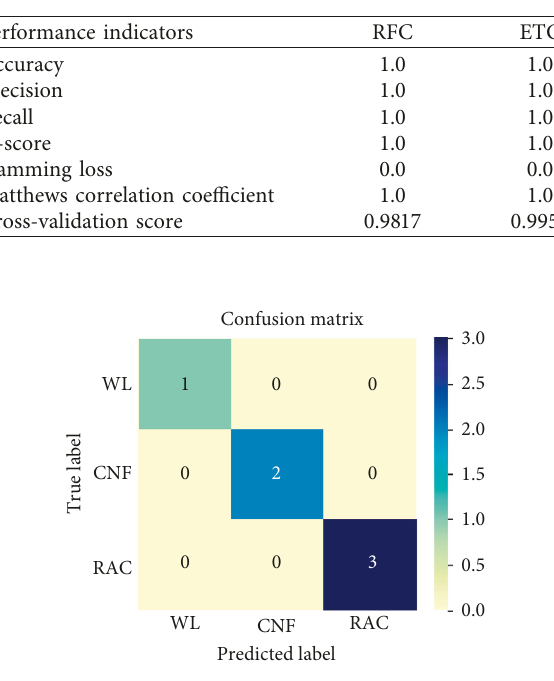
Figure 3: Confusion matrix of both RFC